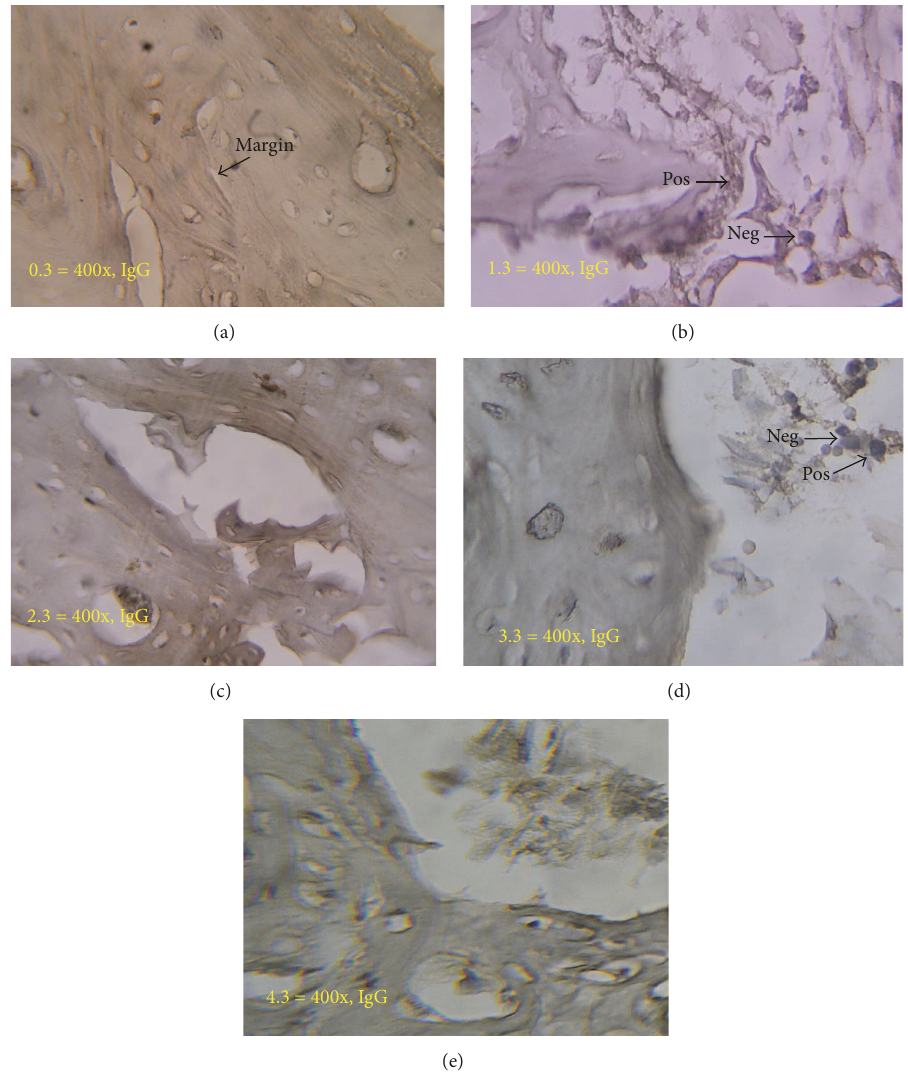
Figure 16: Immunology reaction in week 4. There is no difference in Immunoglobulin-G reaction in control group (a); freeze-dried bovine cortical group (b); allograft freeze-dried cortical New Zealand white rabbit group (c); hydroxyapatite bovine group (d); and demineralized bone matrix bovine group